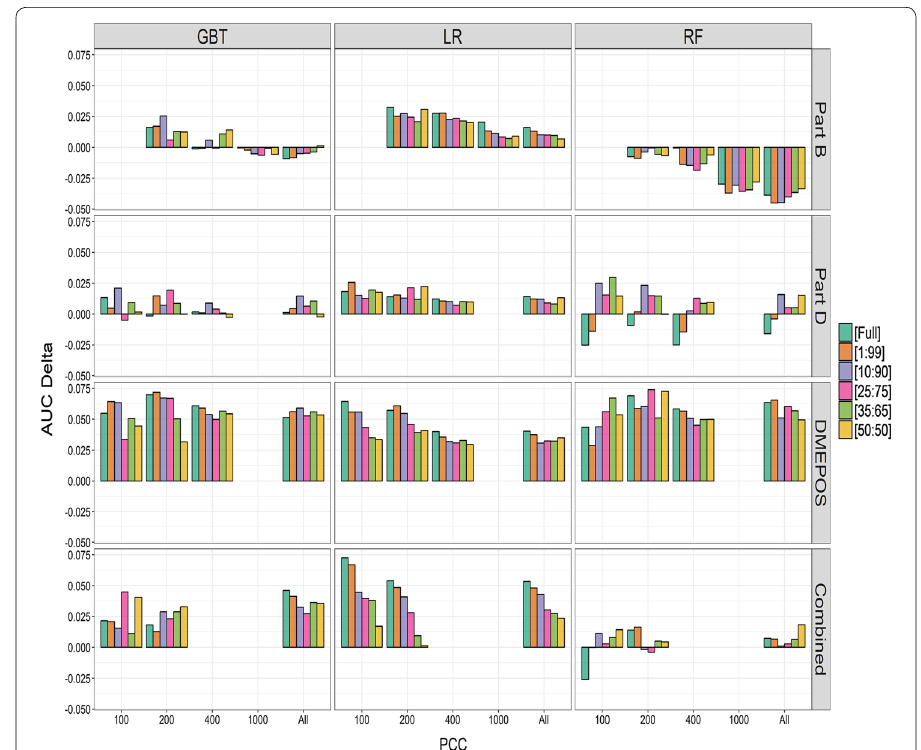
Fig. 2 Average AUC: comparing